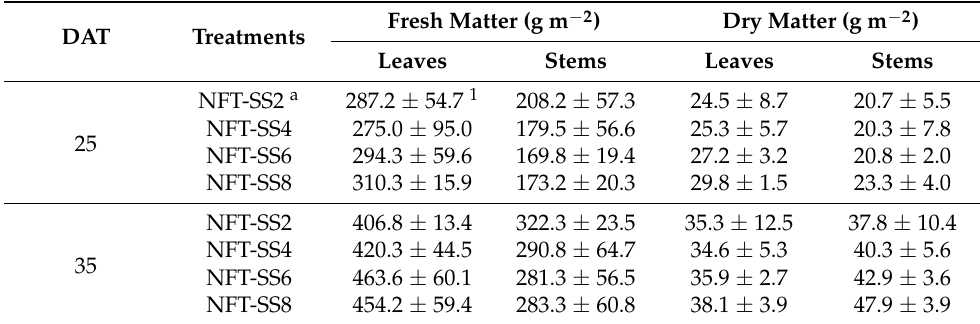
Table 4. Mean fresh and dry matter (g m − 2 ) ( ± SE) of leaves and stems of basil plants irrigated through different saline regimes during the second experimental